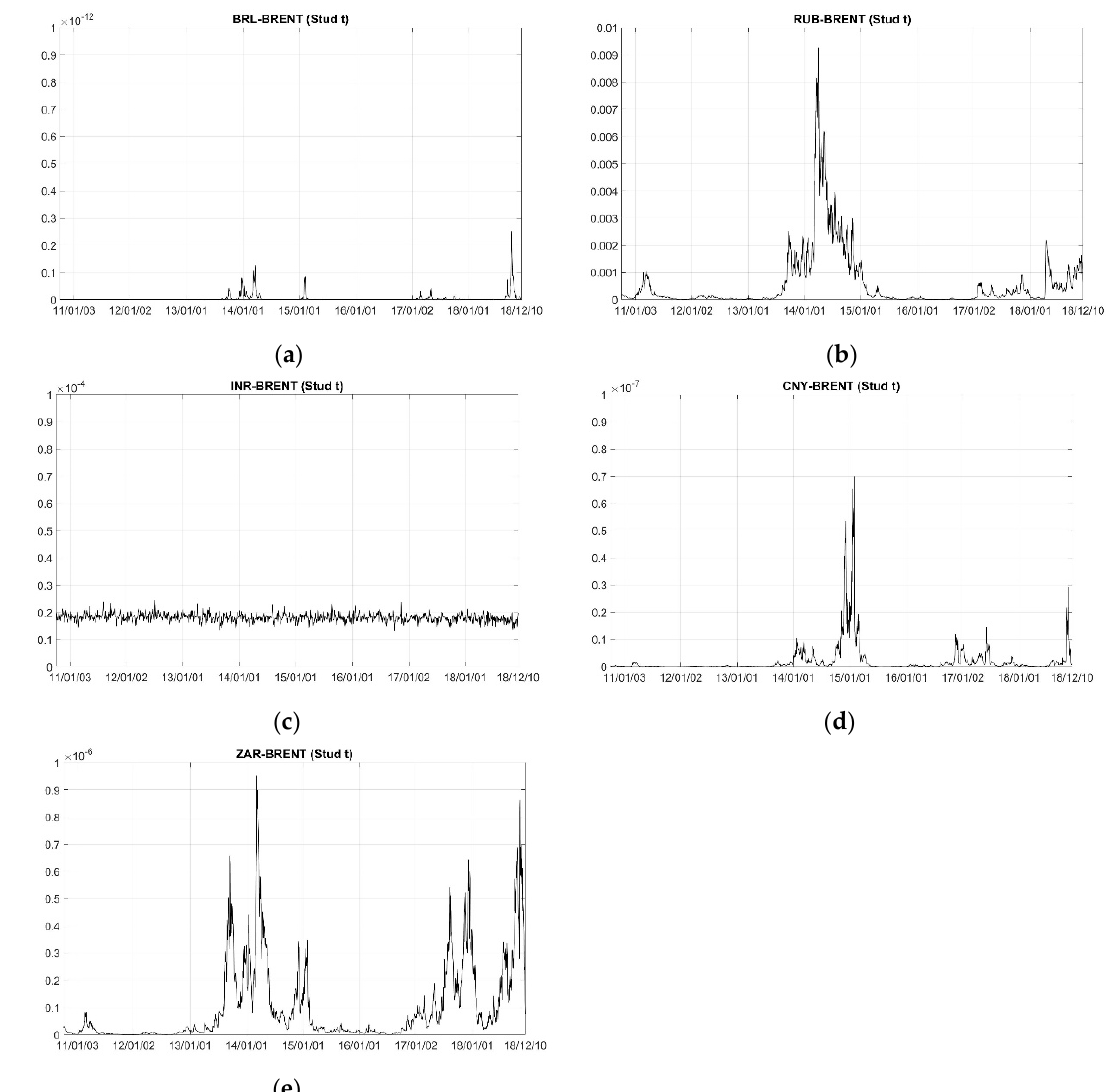
Figure A2. Conditional tail dependence from the time-varying copula models. ( a – e ) refer to pair of BRL–BRENT, RUB–BRENT, INR–BRENT, CNY–BRENT and ZAR–BRENT pairs, respectively.